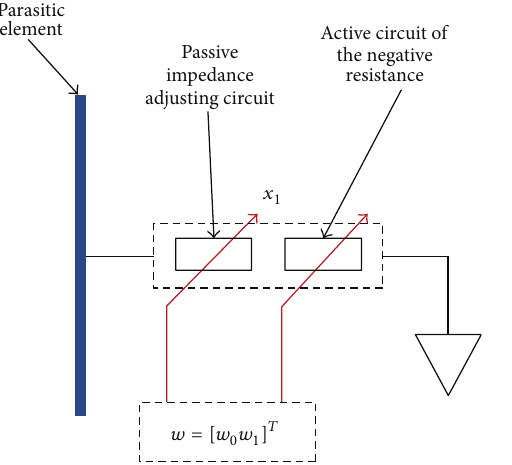
Figure 3: Topology of impedance control for the parasitic antenna.